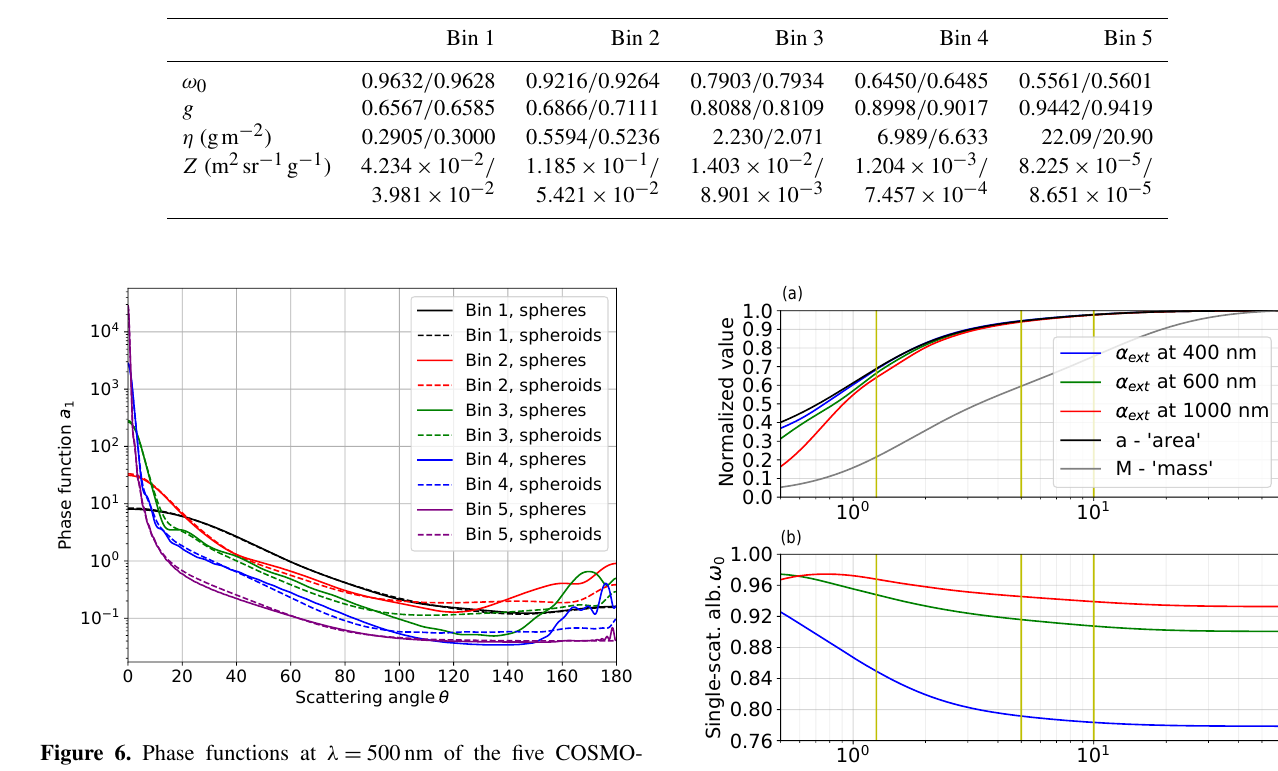
Table 4. Optical properties at λ = 500nm of the five COSMO-MUSCAT dust size bins. Two cases for the particle shape are considered: spheres / prolate spheroids. For details, see text.